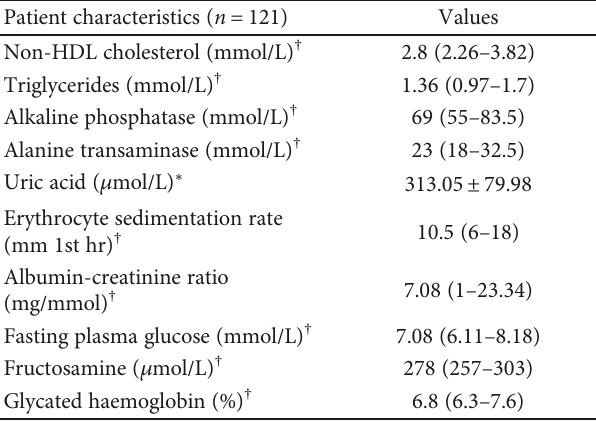
Table 1: Baseline demographic and clinical fi ndings of study population.